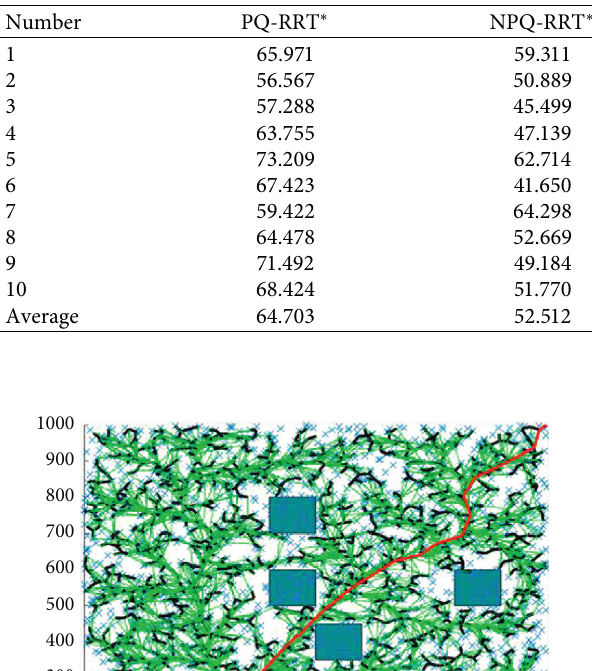
Table 1: Comparing the time of attitude adjustment.